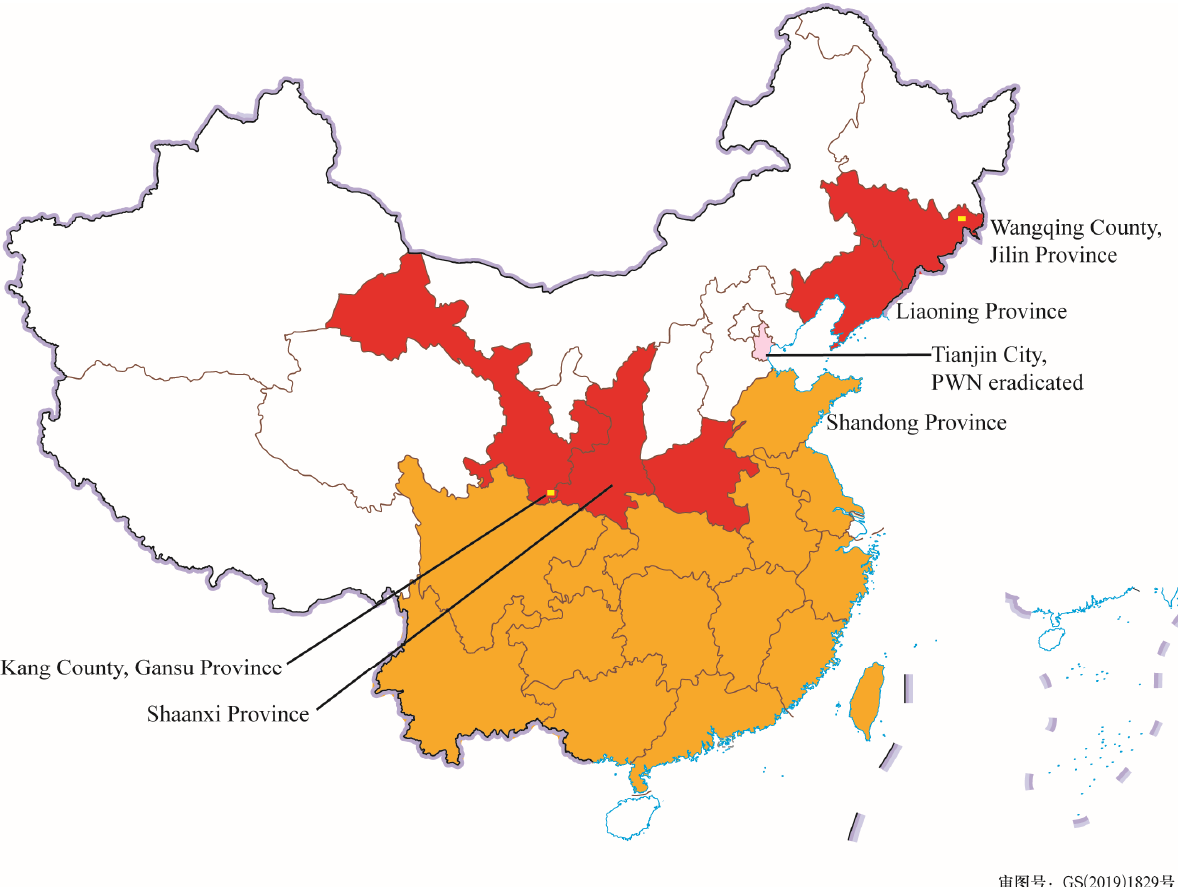
Figure 1. Pine wilt disease epidemic provinces in China (2022). The orange and red-filled areas are the provinces with PWD. In the pink-filled area, PWD has been eradicated. The yellow squares are marked as the most frontier epidemic areas in Northwest and Northeast China.